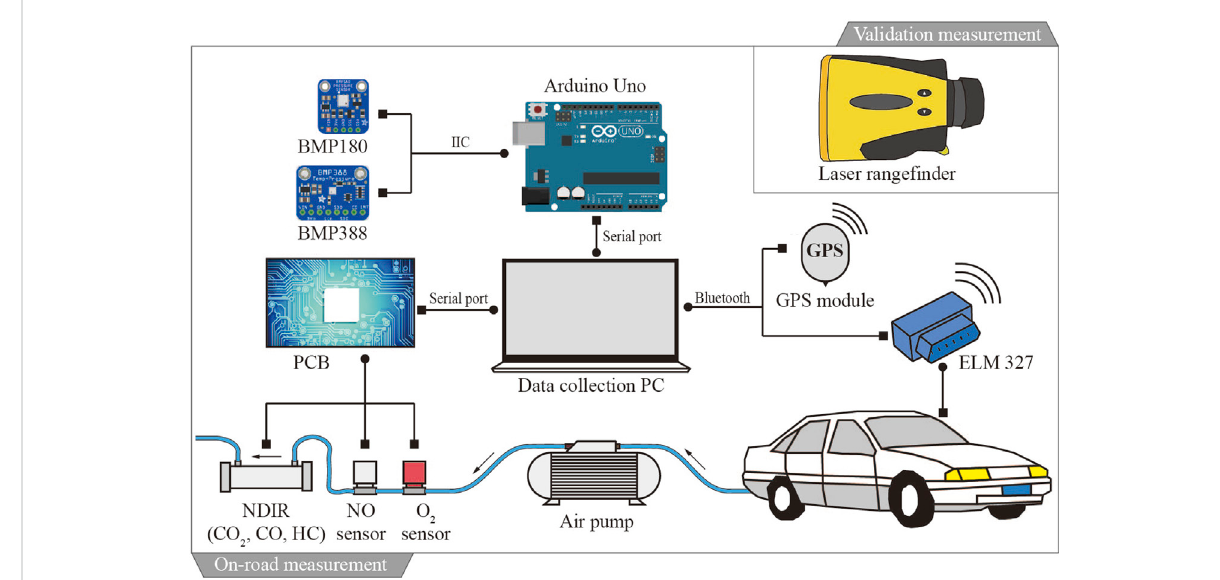
FIGURE 1 Measurement devices used in the